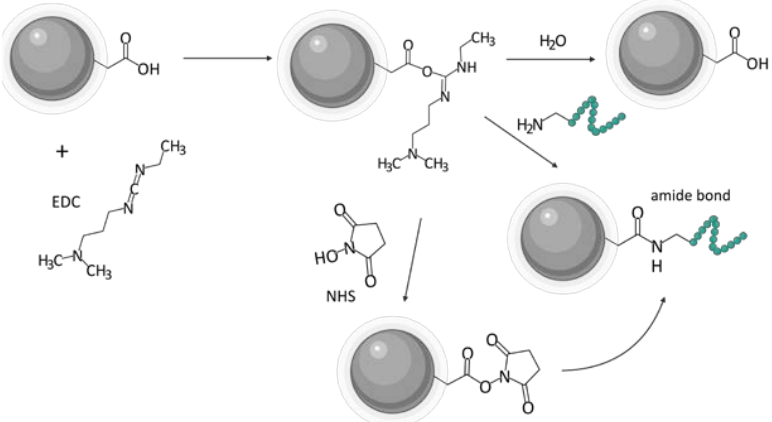
Figure 5. Scheme of the EDC/NHS chemistry of ligand incorporation on the example of carboxylic group tethered nanoparticle. Created with BioRender.com. Chemical structures sketched with MarvinSketch 22.13 (ChemAxon Ltd., Budapest, Hungary).